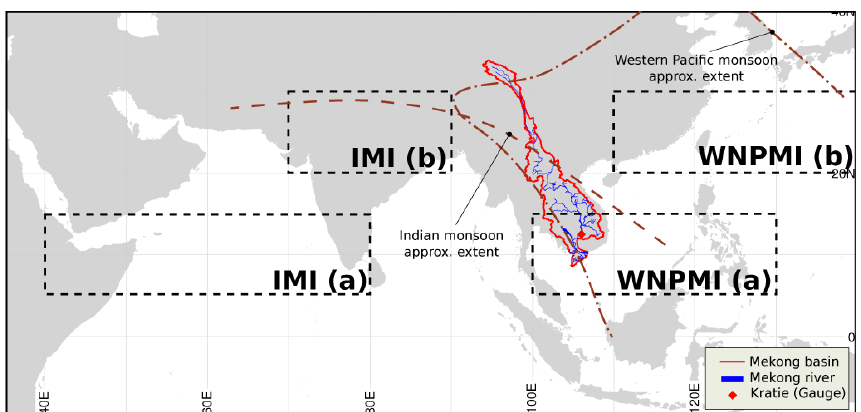
Figure 1. South and Southeast Asia. The Mekong River is depicted, together with the gauge used as data source in this study. The Mekong River is located in the transition zone between the Indian and the Western Pacific monsoon regimes (maximum monsoon extents adapted from Holmes et al., 2009). The boxes for averaging both IMI and WNPMI are